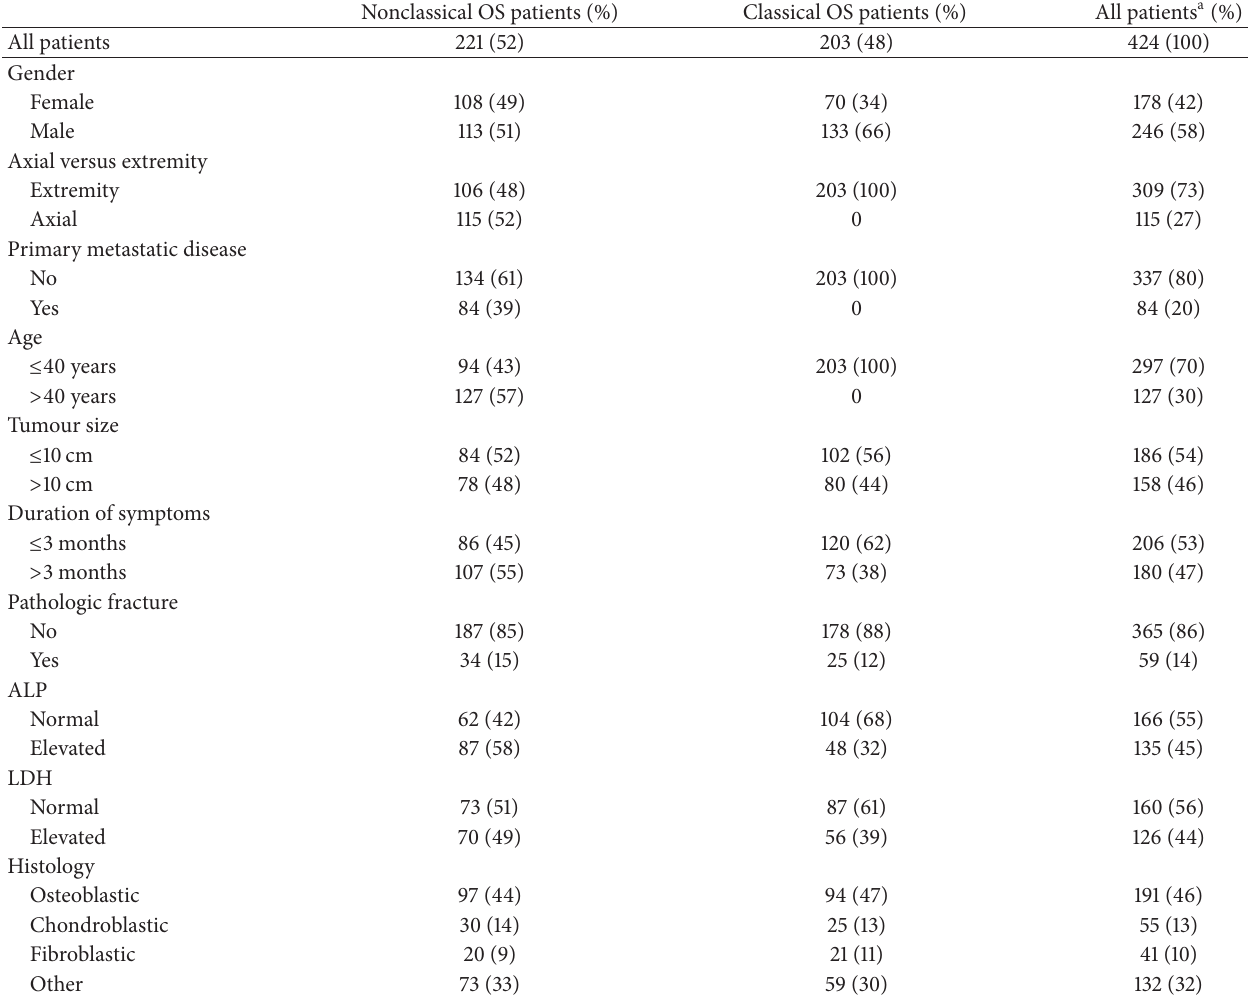
Table 1: Characteristics of nonclassical and classical osteosarcoma (OS) patients,